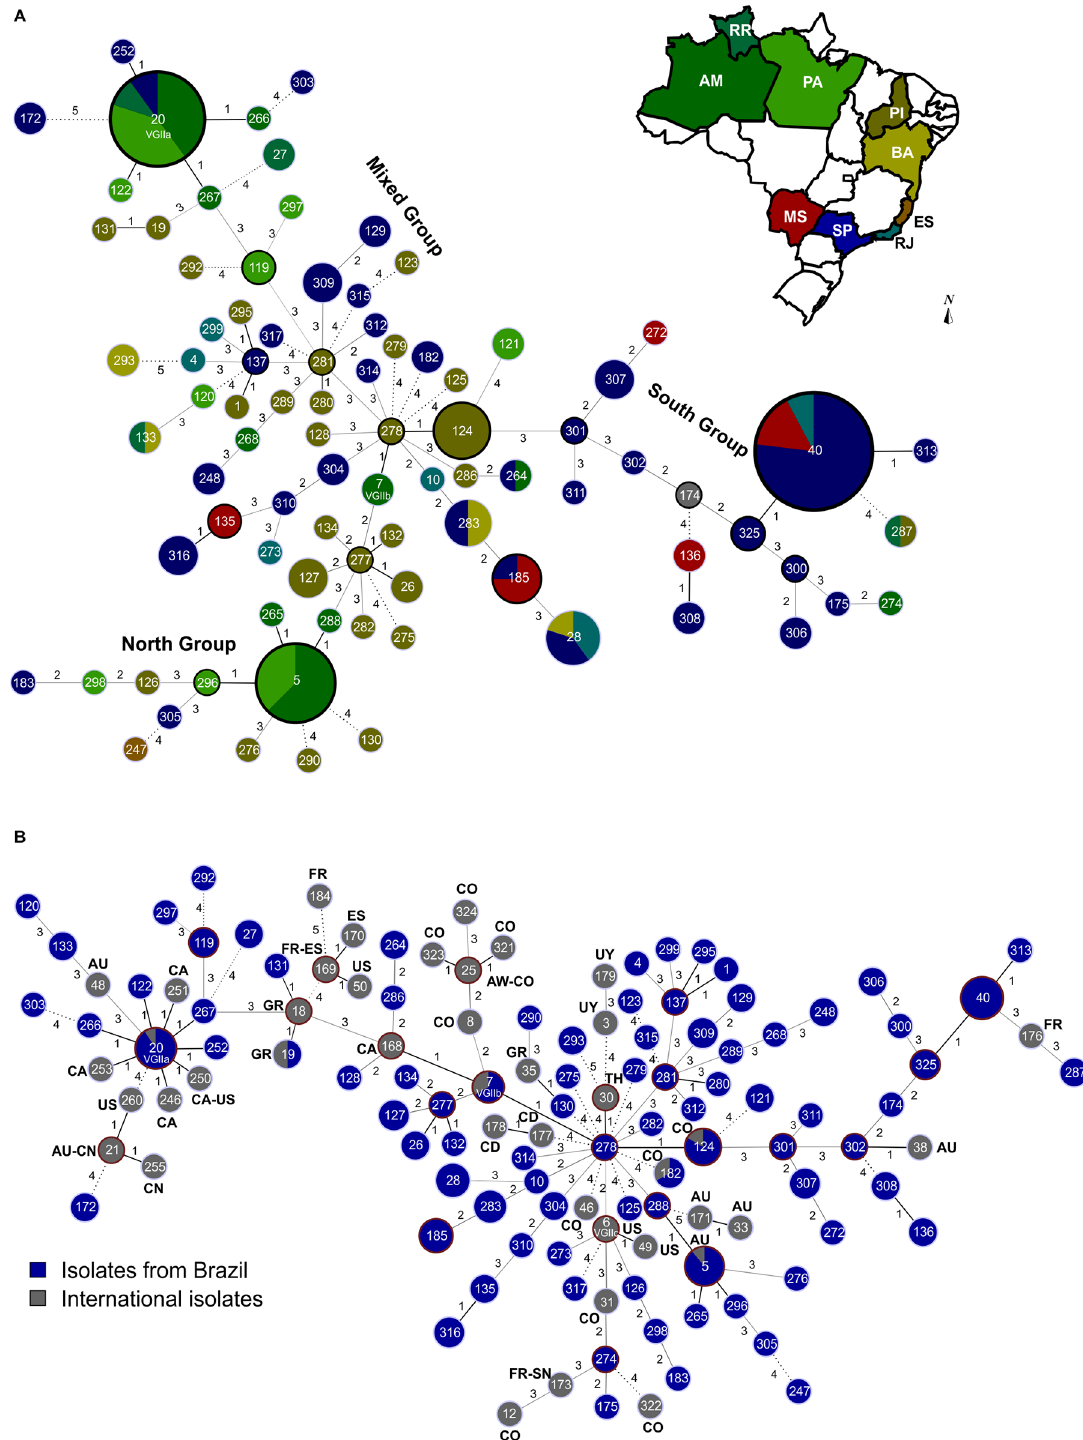
Fig 2. Minimum spanning tree using the goeBURST algorithm. (A) Minimum spanning tree using the goeBURST algorithm showing the high diversity identified among the 145 Brazilian Cryptococcus gattii VGII isolates and nine Brazilian sequence types (ST) according to the state where they were recovered. Dividing the country in two macro regions such as North (composing of the States of Amazonas, Roraima, Pará, Piauí, and Bahia) and South (States of Mato Grosso do